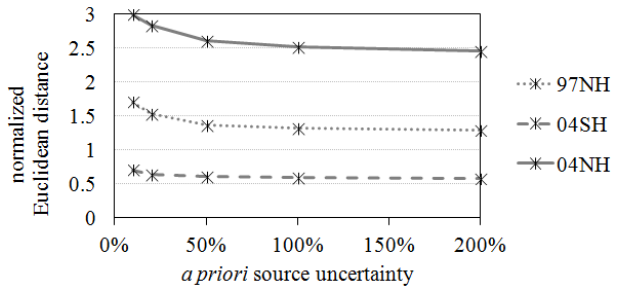
Figure 5. Averaged distance between the measurements and a posteriori CO concentrations.